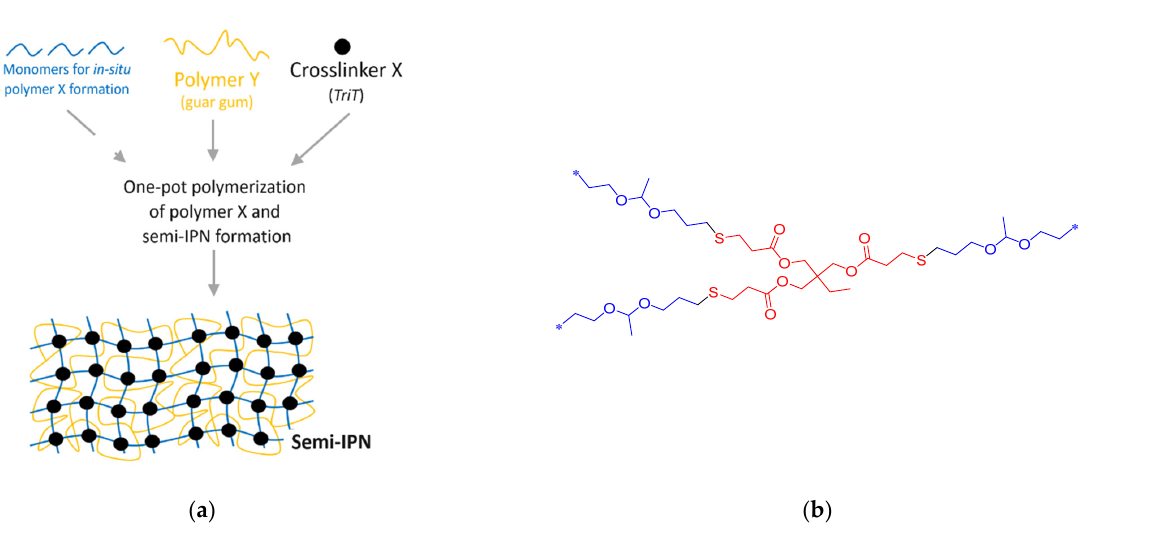
Figure 7. ( a ) Schematic representation of semi-IPN formation. ( b ) Example of the cross-linking point in the 3D framework by reaction of TriT with the diallyl B monomer.